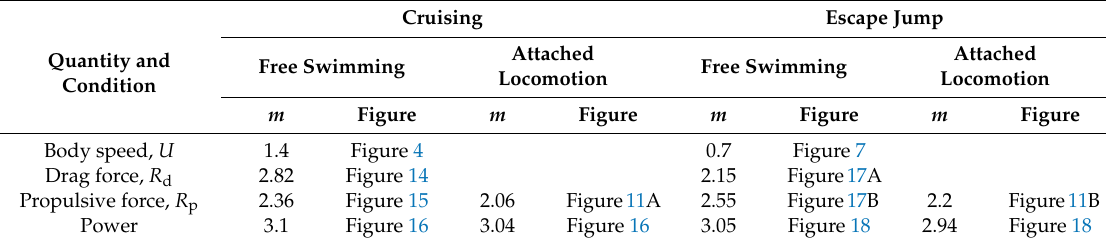
Table 5. Exponents m in scaling relations versus body length, L m